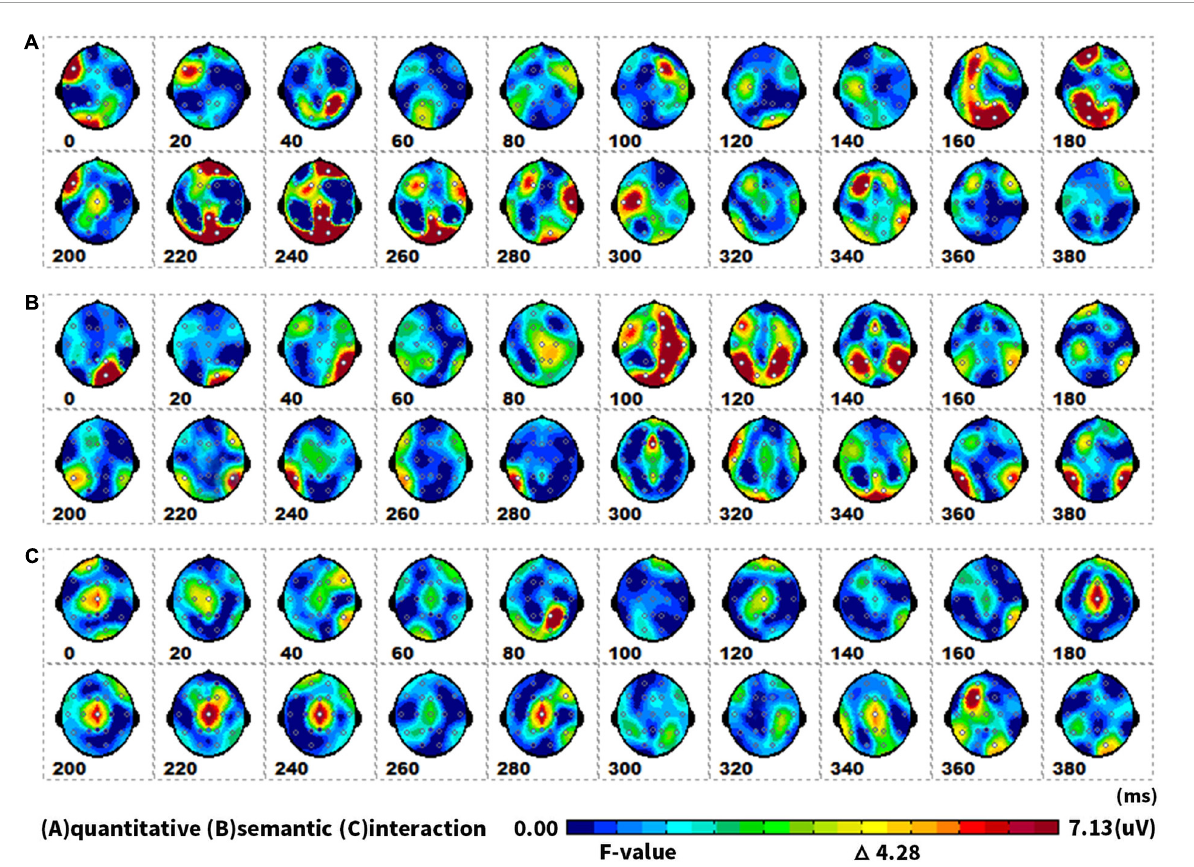
FIGURE6 The spatiotemporal patterns of SPM (f) (0 to 400 ms) are derived from the two-way (semantic: animate vs. inanimate, and quantitative: singular vs. plural) repeated measures ANOVA: (A) the quantitative effect, (B) the semantic effect, and (C) the interaction effect. Each map was interpolated from the average F -values within the fixed 20-ms time window, and the bright yellow bin of the color scale corresponded to the 0.05 significance threshold: F ( 1 , 23 ) = 4.28. The white dots represented the electrode sites with significant